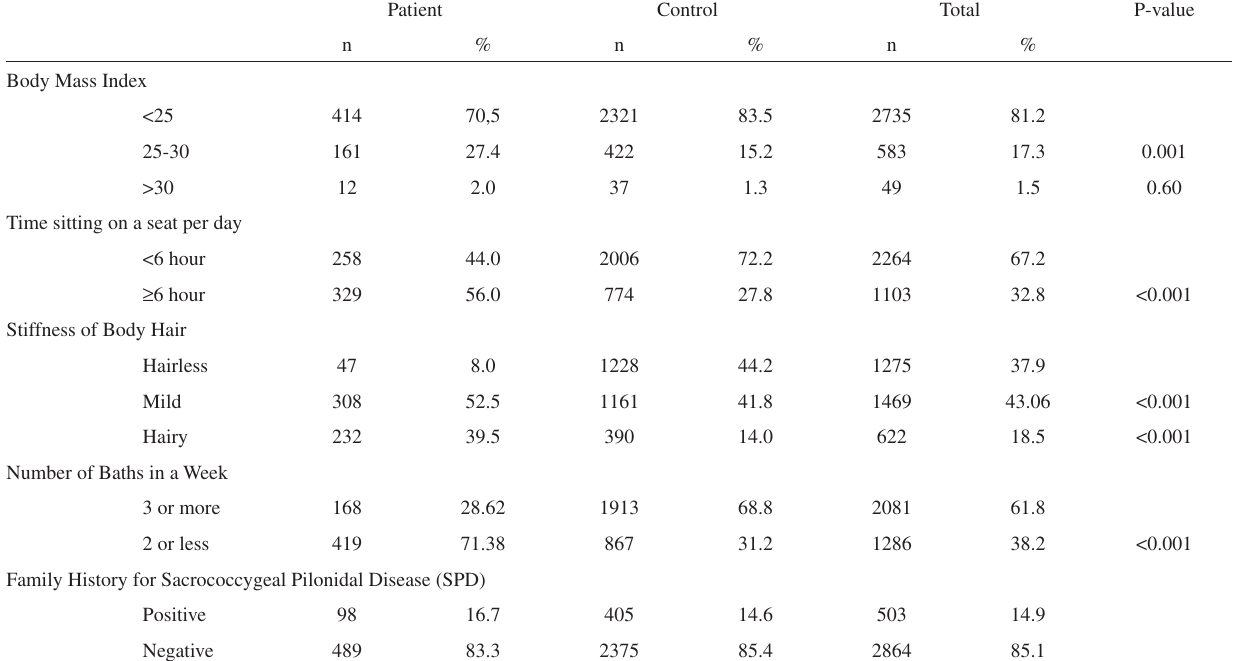
Table 3- Distribution of risk factors in the patient and control